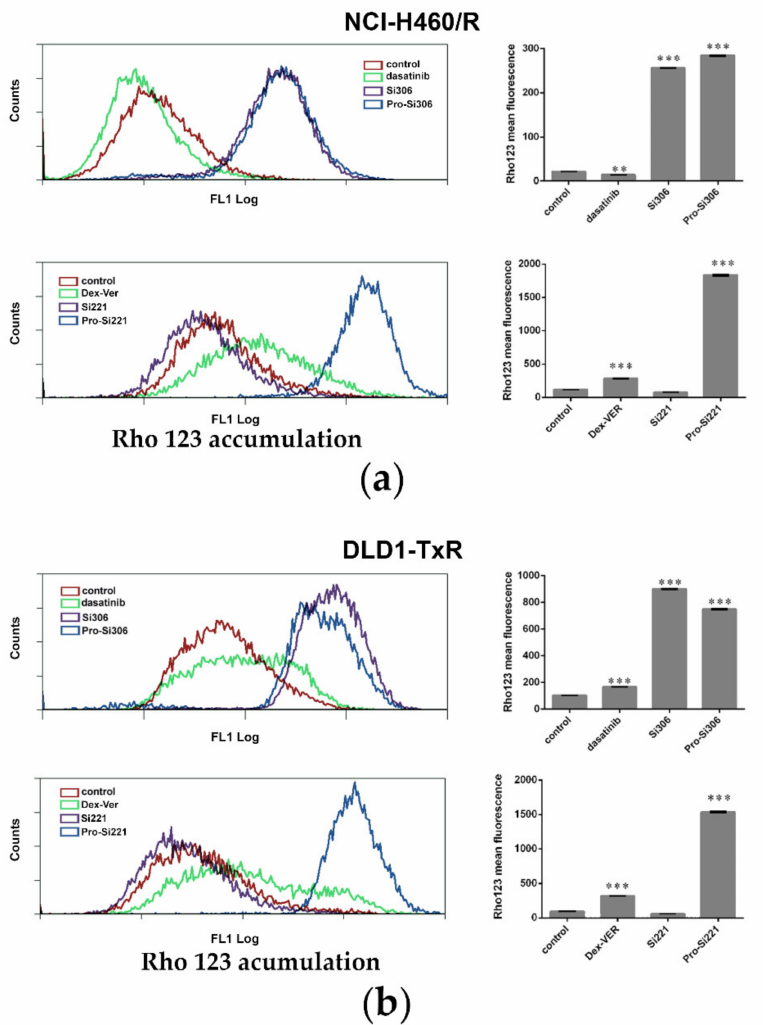
Figure 2. SFK inhibitors suppress P-gp activity. Flow-cytometric profile and the mean fluorescence intensity of Rho123 accumulation assessed after 30-min treatment with 10 µ M Si306, pro-Si306, Si221, and pro-Si221 in ( a ) NCI-H460/R and ( b ) DLD1-TxR cell lines. Dasatinib and Dex-VER are included as reference compounds. Three independent experiments were performed, and a minimum of 10,000 events were collected for each experimental sample. The fluorescence intensity of Rho123 accumulation is presented as the mean ± SEM. Statistically significant differences between untreated control and treated samples: p < 0.01 (**), p < 0.001 (***). Therefore, the concentration-dependent inhibition of P-gp activity was further studied with Si306, pro-Si306, and pro-Si221 in NCI-H460/R and DLD1-TxR cells. To that end, the accumulation of Rho 123 was examined in MDR cancer cells after treatment with increasing concentrations of SFK inhibitors and compared with the effects of the known P-gp